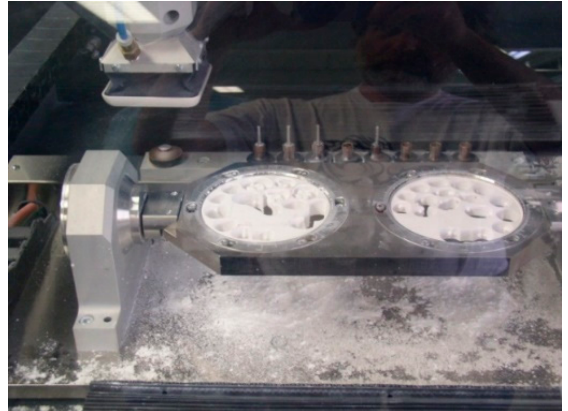
Figure 2. Milling machine Coritec250i (imes-icore).